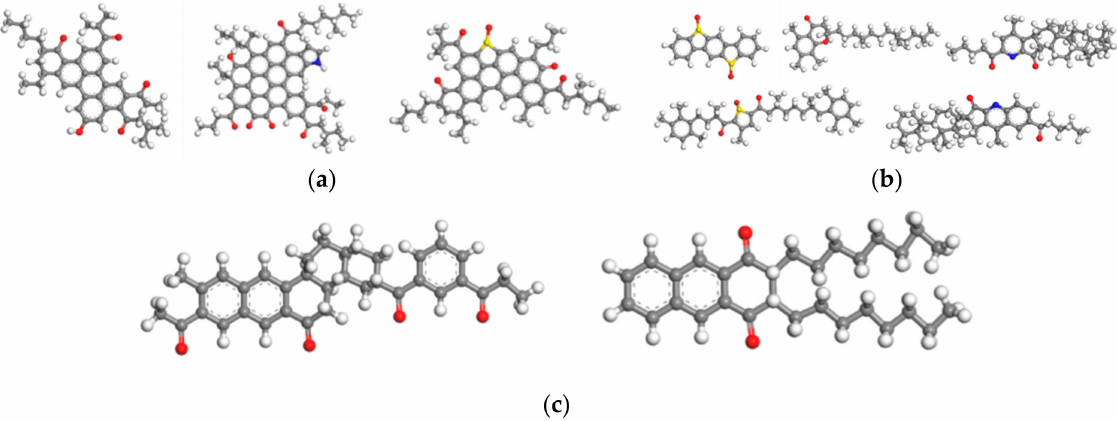
Figure 2. Molecular structure model of aged asphalt: ( a ) Asphaltenes; ( b ) Polar aromatics; ( c ) Naph- thene aromatics (Oxygen atoms are